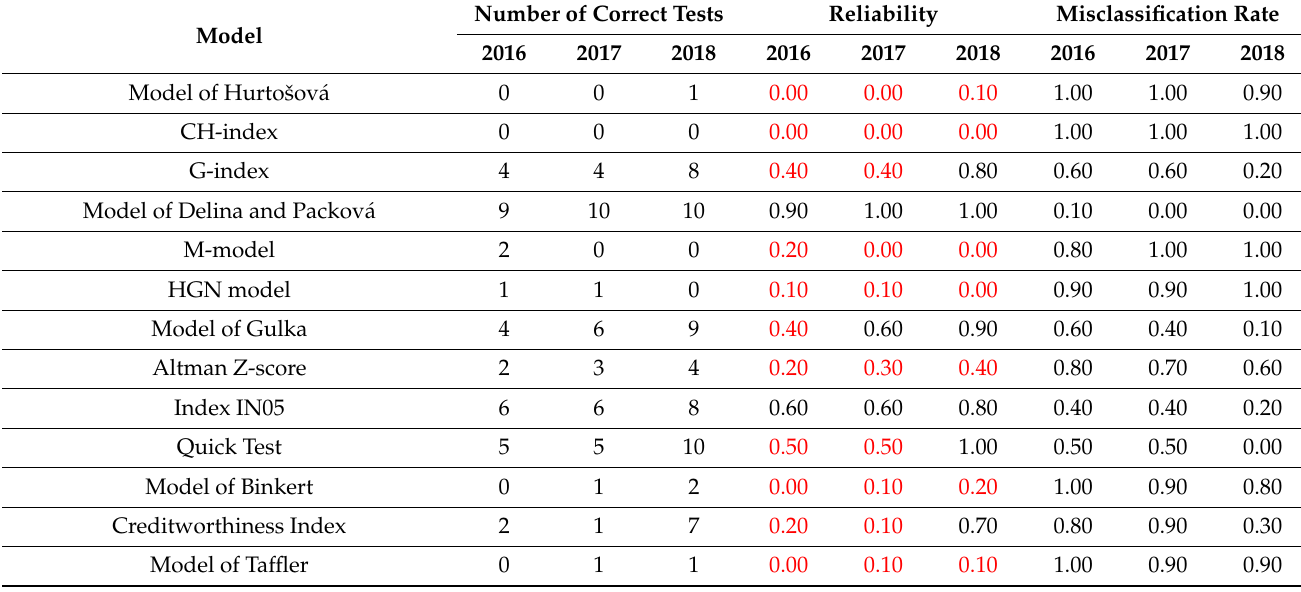
Table 8. Results of testing default prediction models on non-prosperous companies in construction sector in 2016–2018. Model